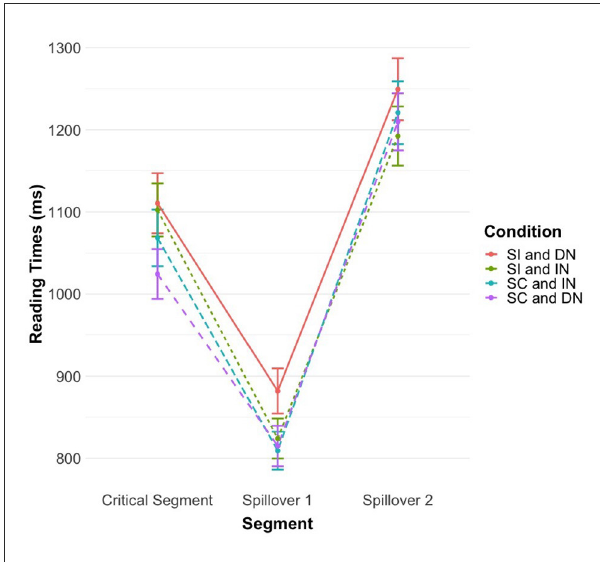
FIGURE1 Mean reading times in milliseconds for Experiment 1. Mean and standard error reading times (raw data) for each segment in Experiment 1. SC, stereotype-congruent; SI, stereotype-incongruent; DN, definite NP; IN, indefinite